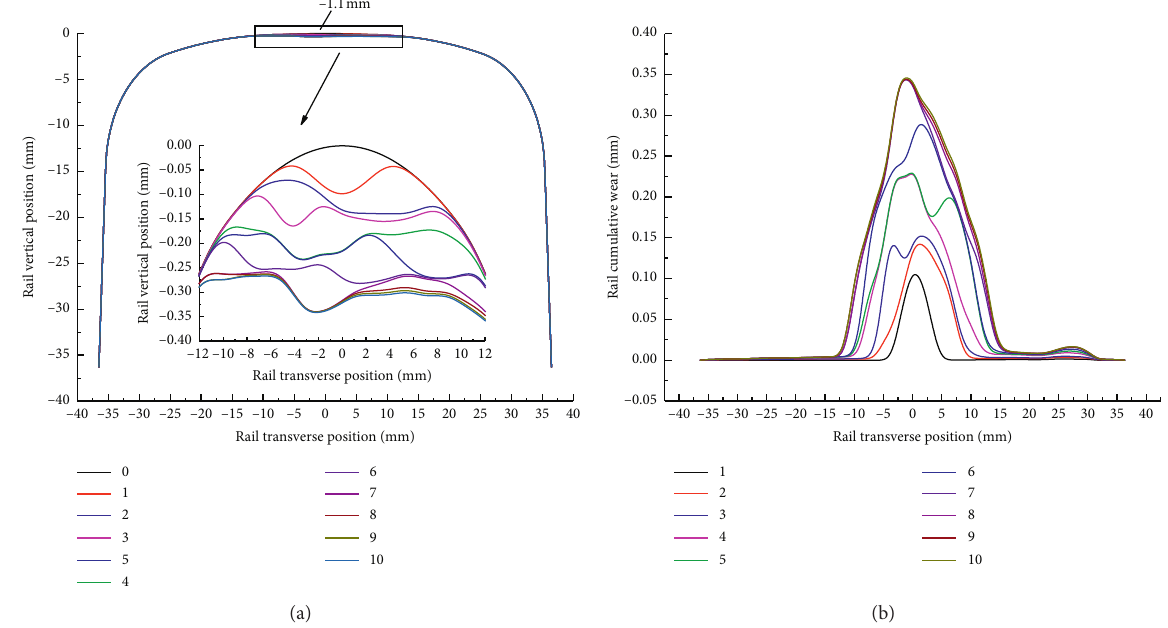
Figure 8: Inner rail. (a) Profile contrast diagram. (b) Cumulative wear contrast